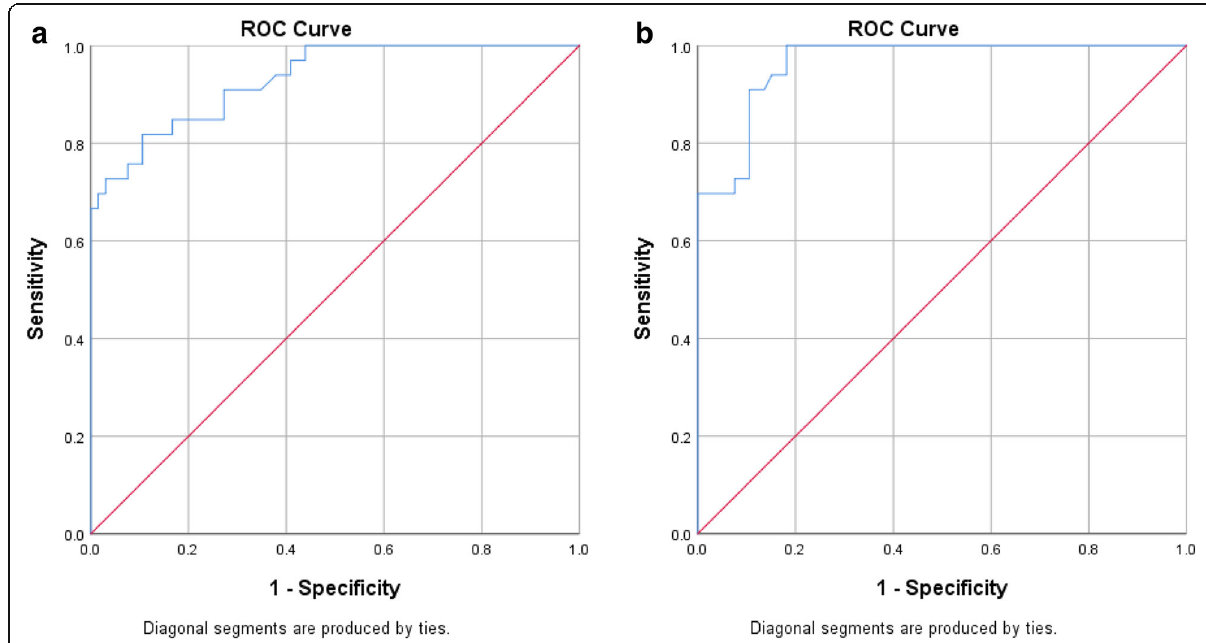
Fig. 1 a Receiver operating characteristic (ROC) curve for the E mean of SWE; E mean the mean elasticity index of the stiffest portion of the nodule. b Receiver operating characteristic (ROC) curve for the ER of SWE; ER the ratio of mean elasticity indices of the nodule and the